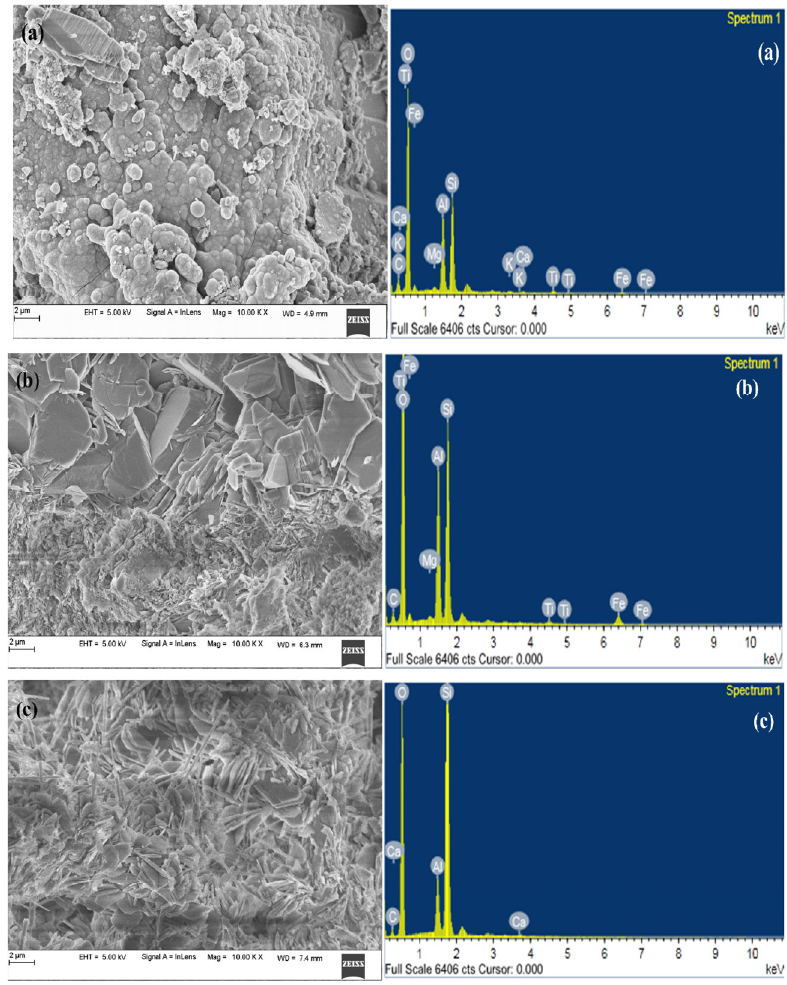
Fig. 3 SEM micrographs and EDS analysis of (a) medium-grained sandstone, (b) fine-grained sandstone, and (c) fine-grained sandstone